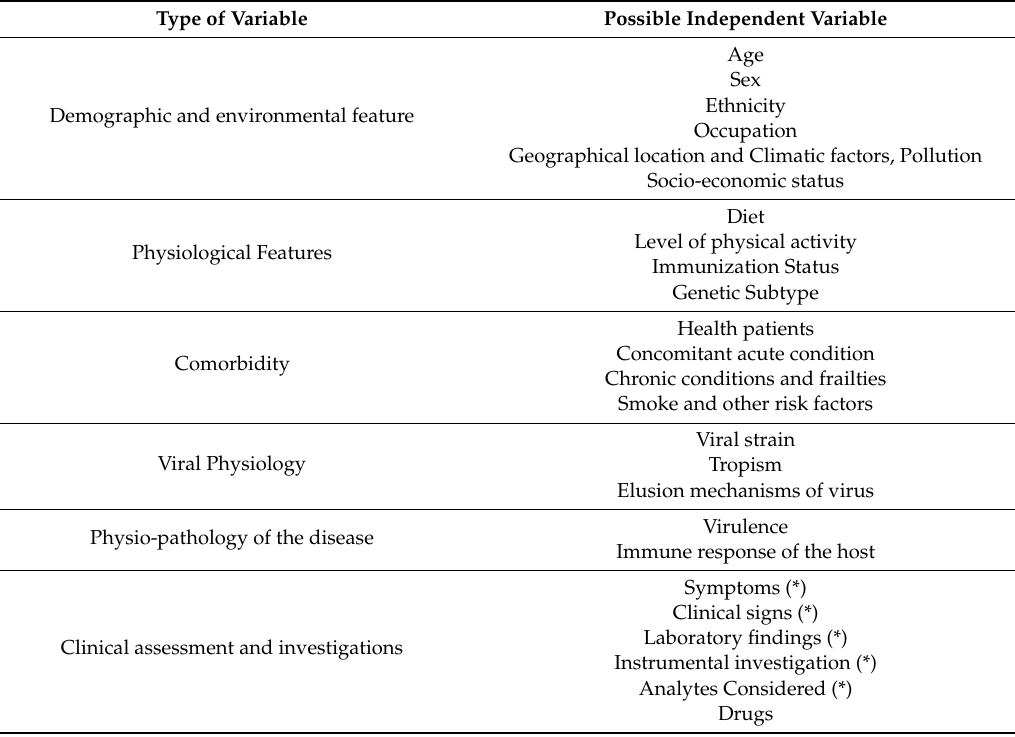
Table 2. Prototypic examples of independent variables that should be considered when clustering the results and evaluating the outcomes. For a well-known disease, some of these variables are known. Therefore, we cannot estimate a priori whether they can or cannot a ff ect the outcome and design the research protocol, accordingly, setting inclusion or exclusion criteria. For COVID-19, the weight of every variable in a ff ecting the outcome of an experimental observation or intervention is generally